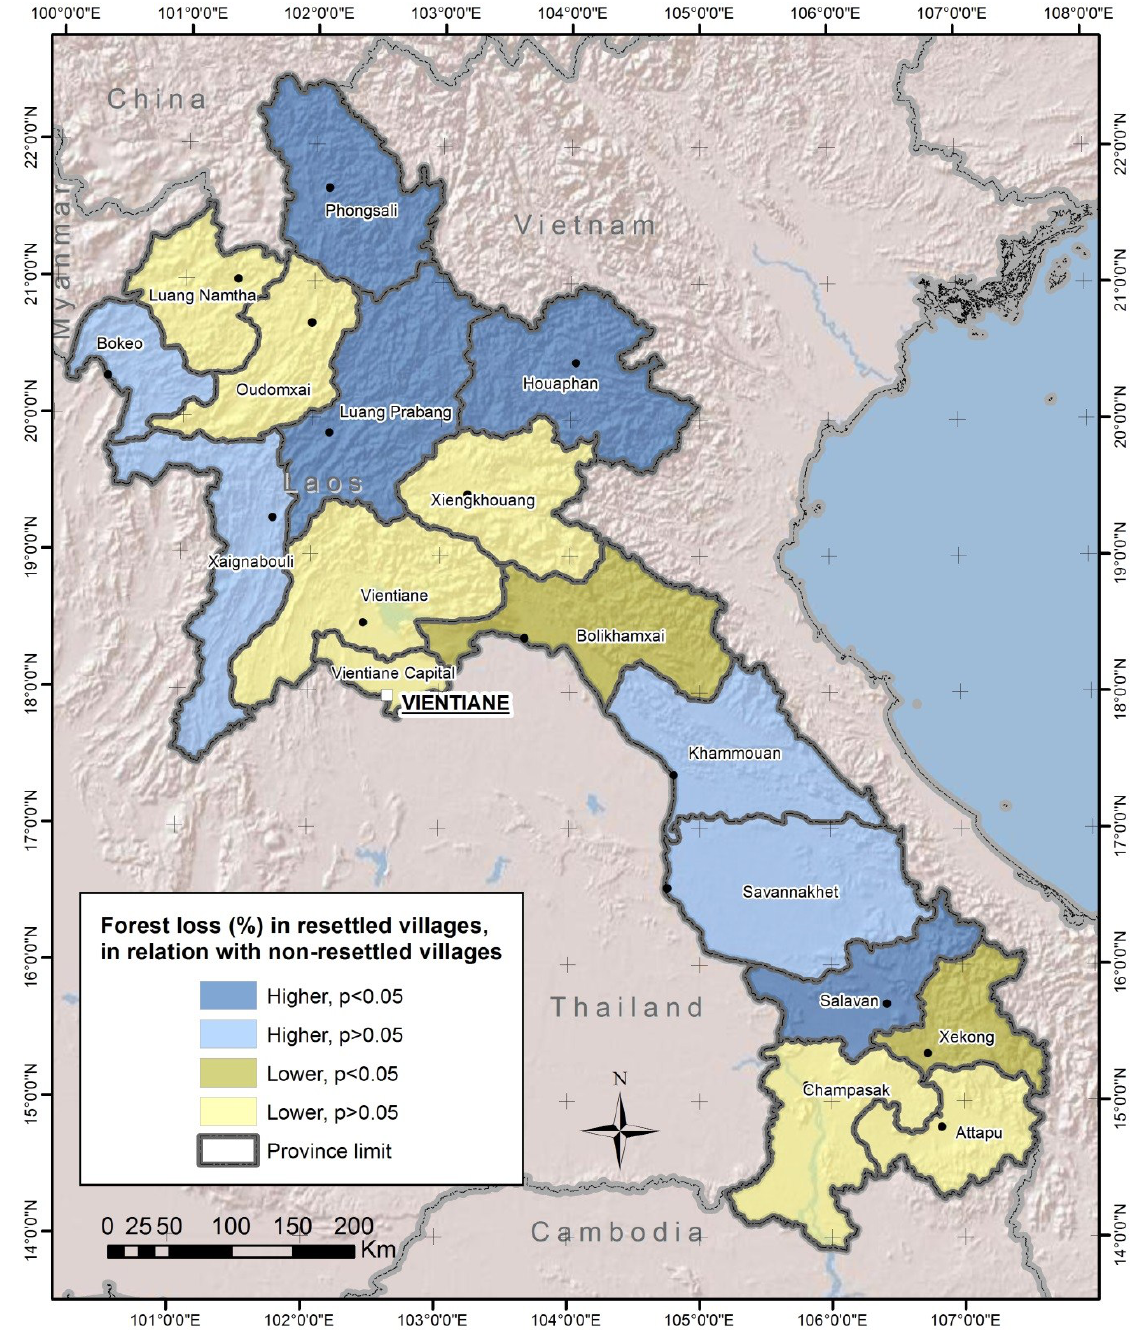
Figure 5. Comparison of forest loss in resettled and non-resettled villages by